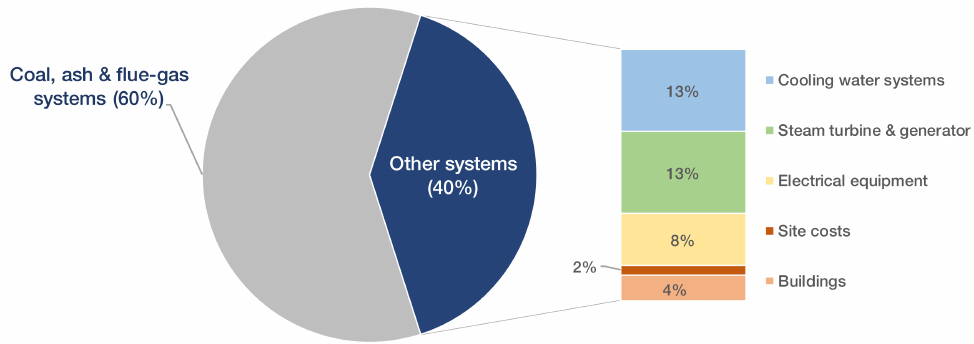
Figure 2. Approximate investment cost distribution for new coal power